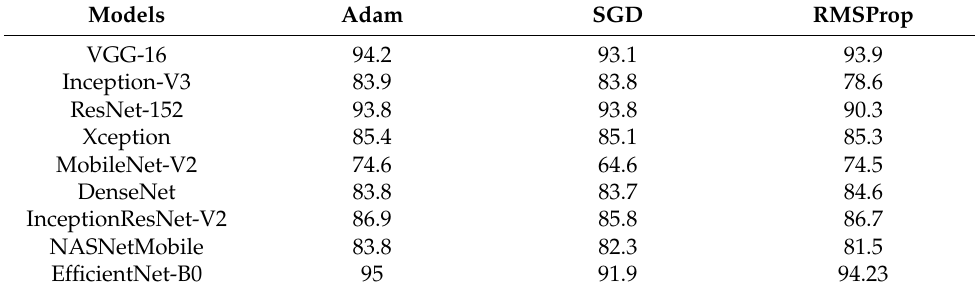
Table 2. Validation accuracy achieved using Adam, SGD, and RMSProp optimizers.